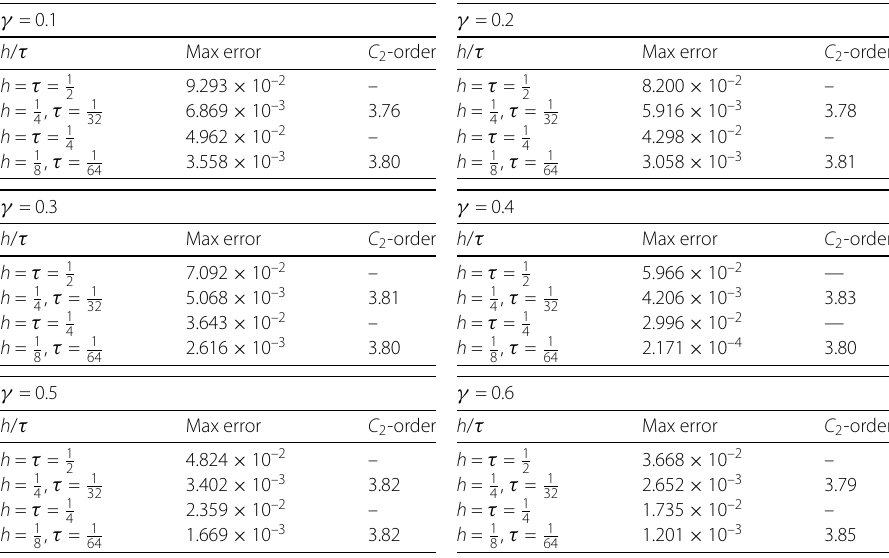
Table 4 C 2 -order of convergence for Test problem 3 γ = 0.1